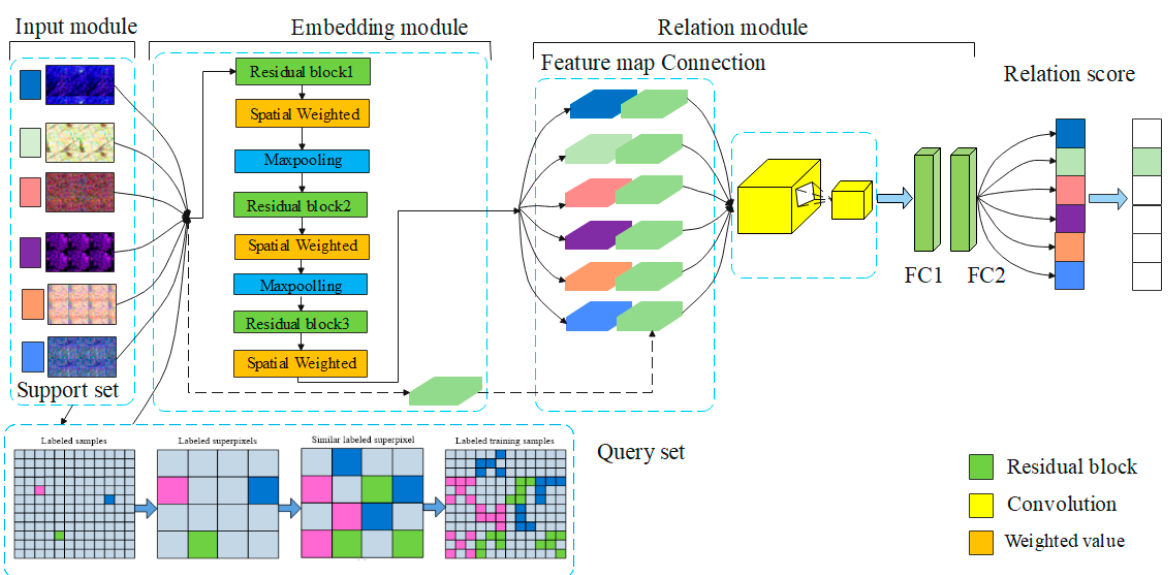
Table 2. The specific parameters of the proposed classification network.